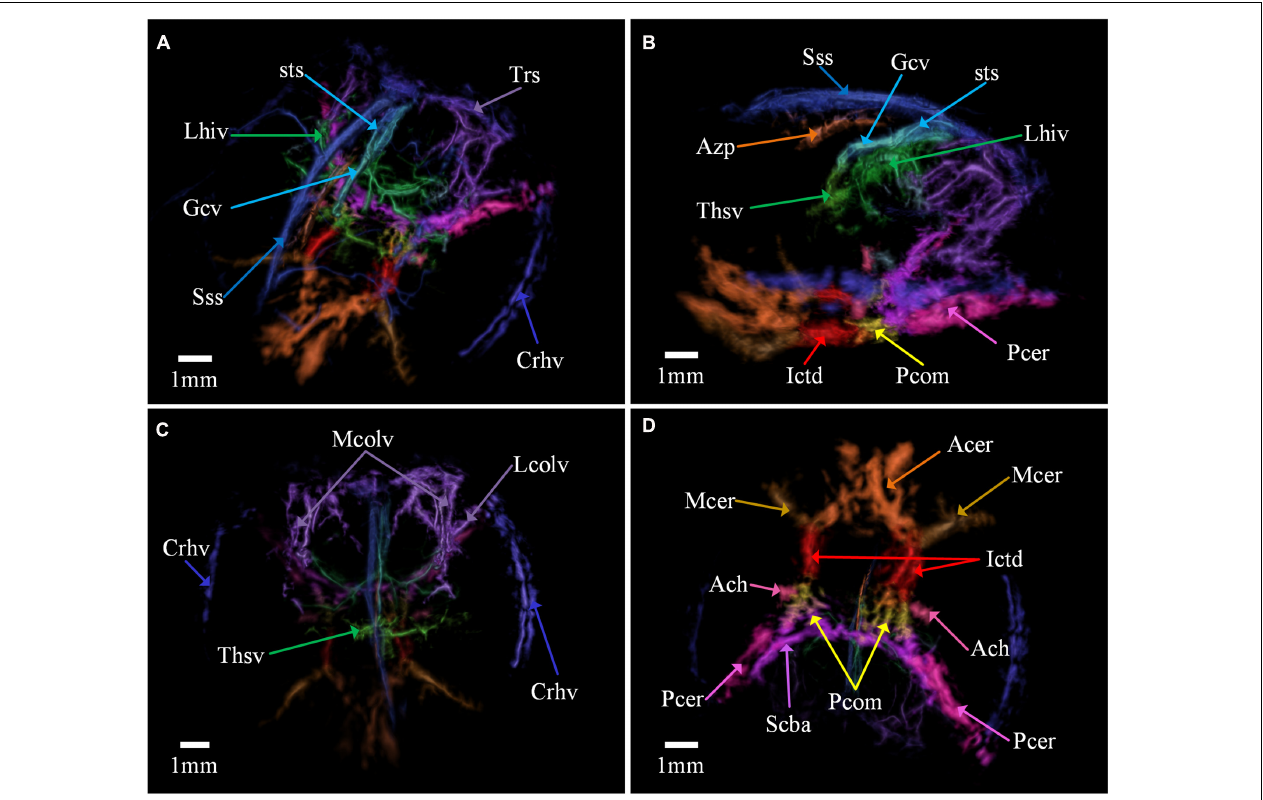
FIGURE 4 | The segmentation result of the cerebovascular structure. (A) The same view with Figure 3B . (B) Left view. (C) Horizontal slice plane at lateral-medial of the brain, inferior view. (D) Bottom view, showing the circle of Willis. Sss, superior sagittal sinus; Trs, transverse sinises; Crhv, caudal rhinal vein; Gcv, vein of galen; sts, straight sinus; Lhiv, longitudinal hippocampal vein; Thsv, thalamostriate vein; Mcolv, medial collicular vein; Lcolv, lateral collicular vein; Ictd, internal carotid artery; Acer, anterior cerebral artery; Mcer, middle cerebral artery; Pcer, posterior cerebral artery; Ach, anterior choroidal artery; Azp, azygos pericallosal; Pcom, posterior communication artery; Scba, superior cerebellar